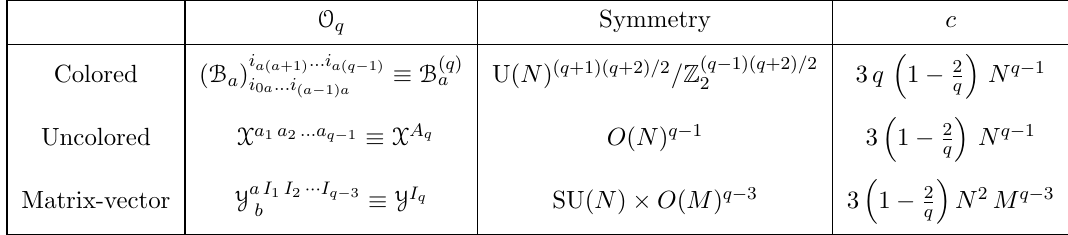
Table 4 . Generalization to models with q-fold